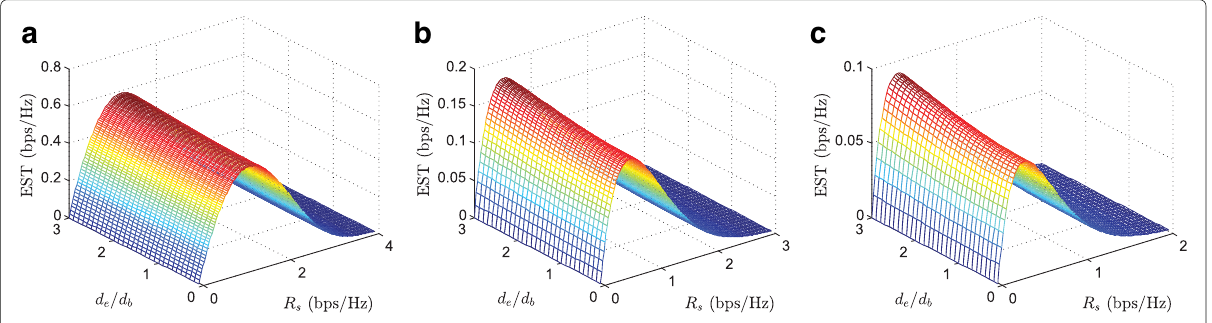
Fig. 3 Relationship between EST and distance ratio ( d e / d b ) on basis of SNR = 3 dB and α = 2.5. a n = 0. b n = 2. c n =